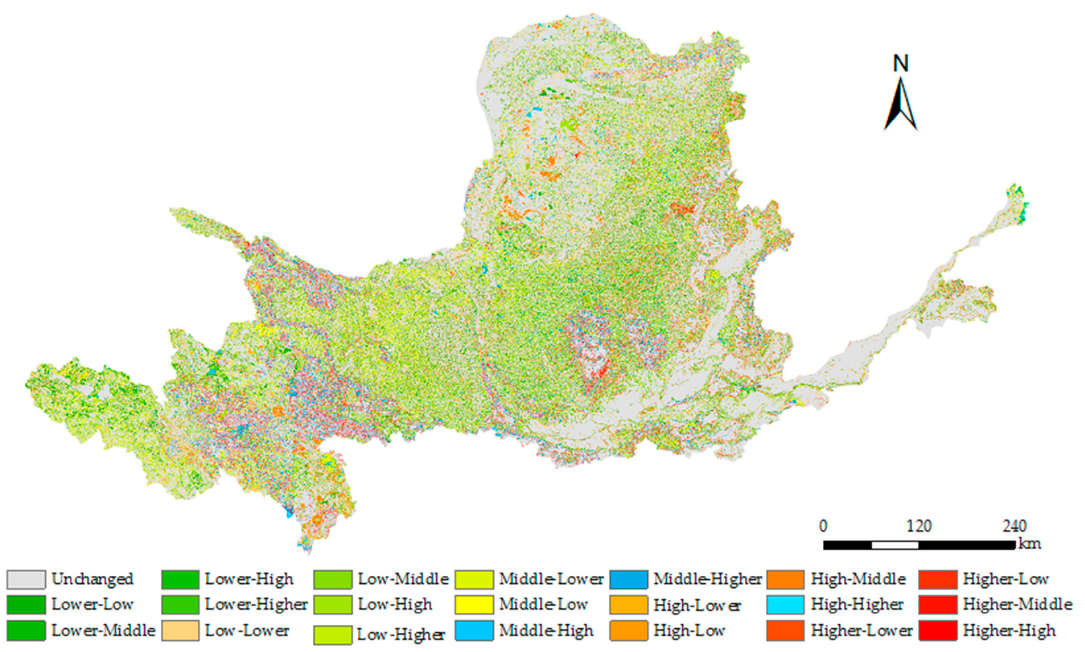
Figure 8. Spatial distribution of changes in habitat quality grade in the Yellow River Basin between 2000 to 2020.